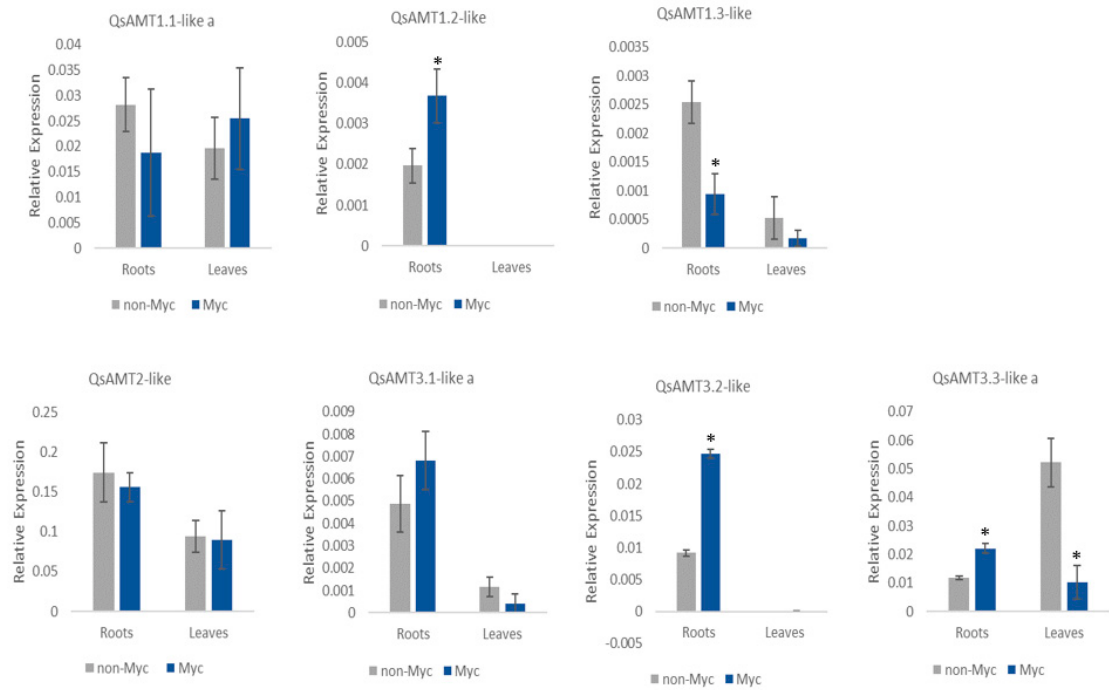
Figure 1. Quantification by qPCR of AMT gene expression in roots and leaves of P. tinctorius mycorrhizal (Myc) and non-mycorrhizal (non-Myc) cork oak plants. Values are the means of 3 replicates. Error bars represent standard deviations. The cork oak elongation factor-1-alpha transcript was used as reference. * Indicates significant differences between treatments at p -value < 0.05.